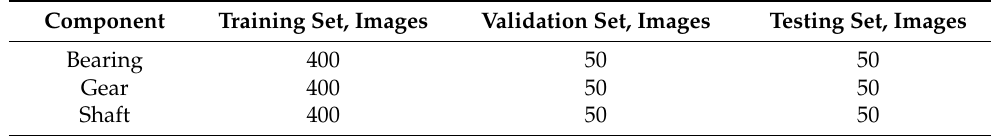
Table 3. Composition of training, validation, and test